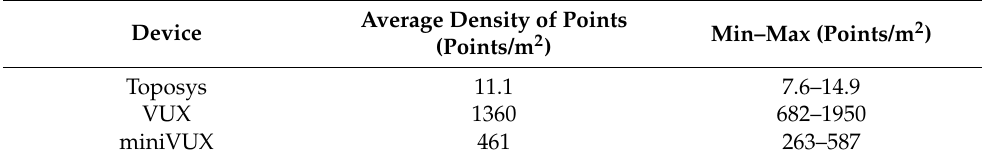
Table 3. The densities of the point clouds used in the